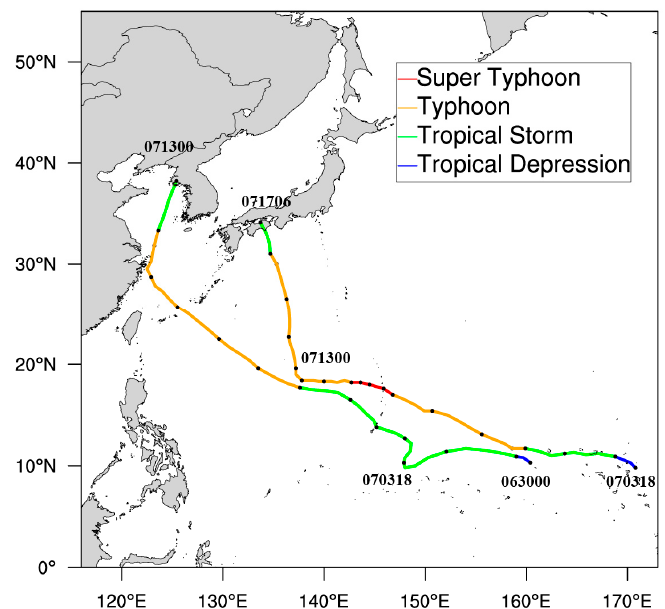
Figure 1. The best tracks from the Joint Typhoon Warning Center (JTWC) for Chan-hom (left, 0000 UTC 30 June–0000 UTC 13 July) and Nangka (right, 1800 UTC 3 July–0600 UTC 17 July), defined as tropical depression (blue), tropical storm (green), typhoon (orange), and super typhoon (red).